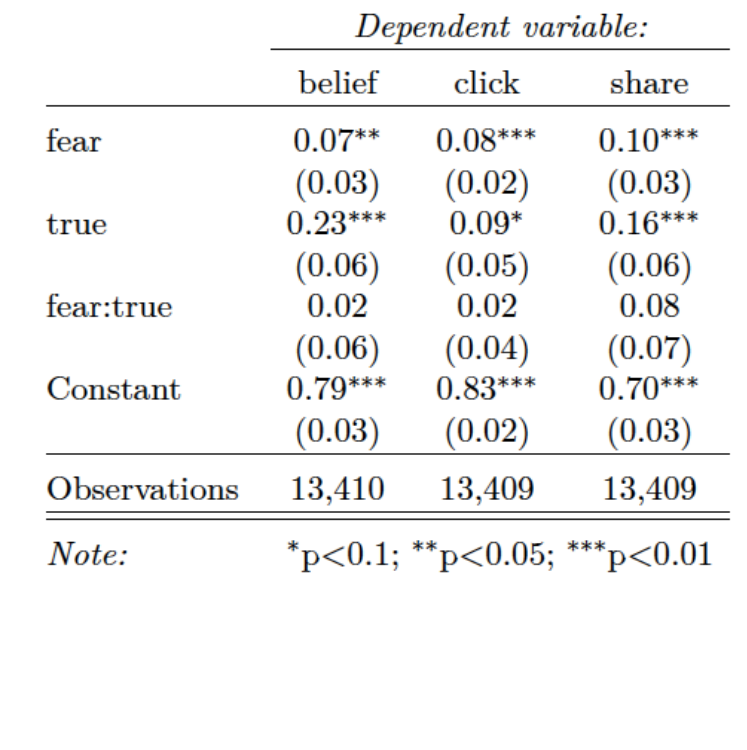
Table B5. Association between fear and belief, click, and share.